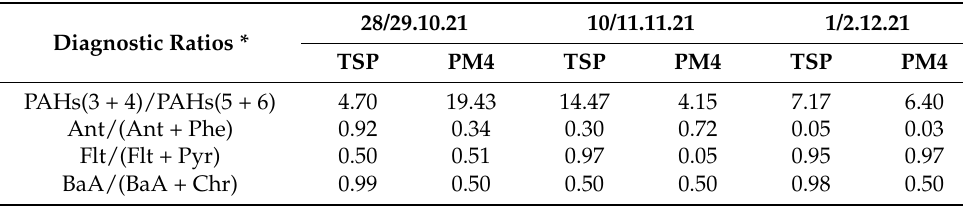
Table 5. The PAH diagnostic ratios in TSP and PM4 samples collected in the garage of the fire station unit.